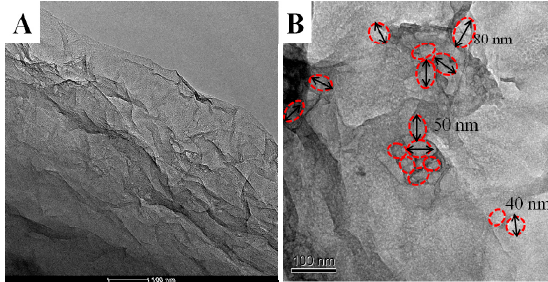
Figure 2. TEM images of product with reaction concentrations of GO 2 mg/mL for 15 days with low ( A ) and high order ( B ).